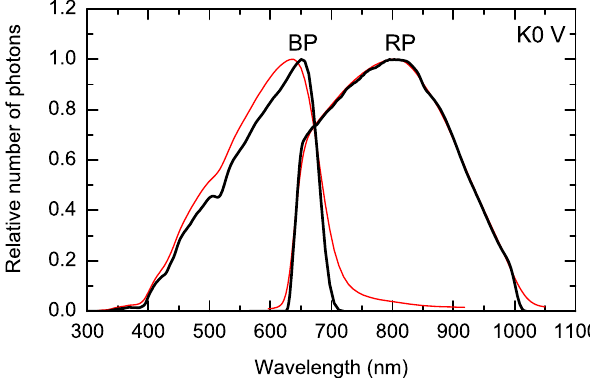
Fig. 5. The same as in Figure 1 but for K0 V type star.